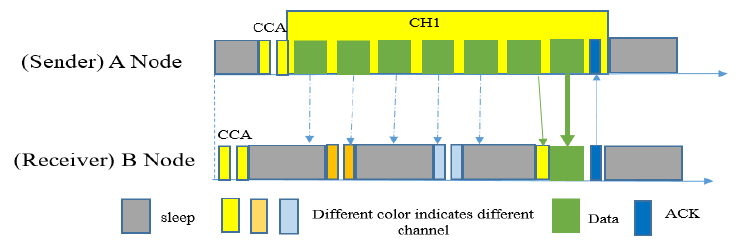
Figure 12. Packet transmission in MiC-MAC [35].